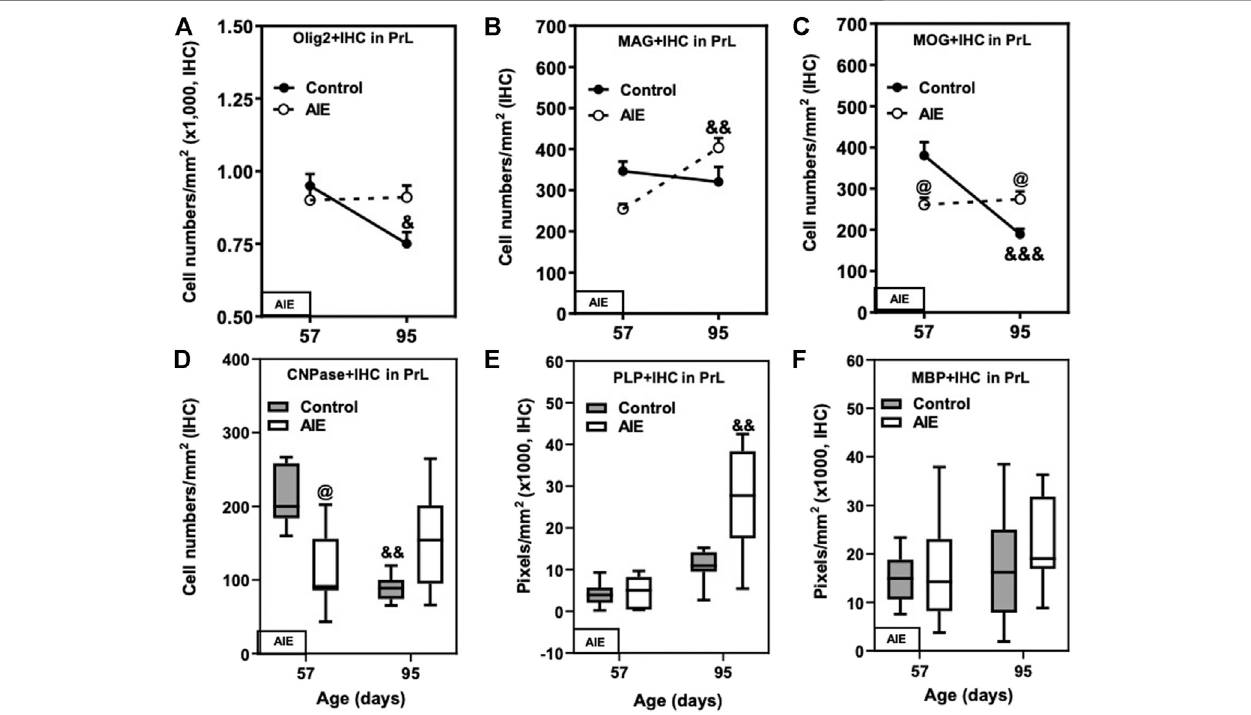
FIGURE5| EffectsofageandAIE onOLmarkersinthefrontalcorticalgray matterprelimbic cortex(PrL). (A) Olig2+IHC expression intheAIEgroupwasgreaterat P95 than in controls (21%). Olig2+IHC expression showed maturational decline in controls (20%), but not in the AIE group. (B) MAG + IHC expression in the AIE